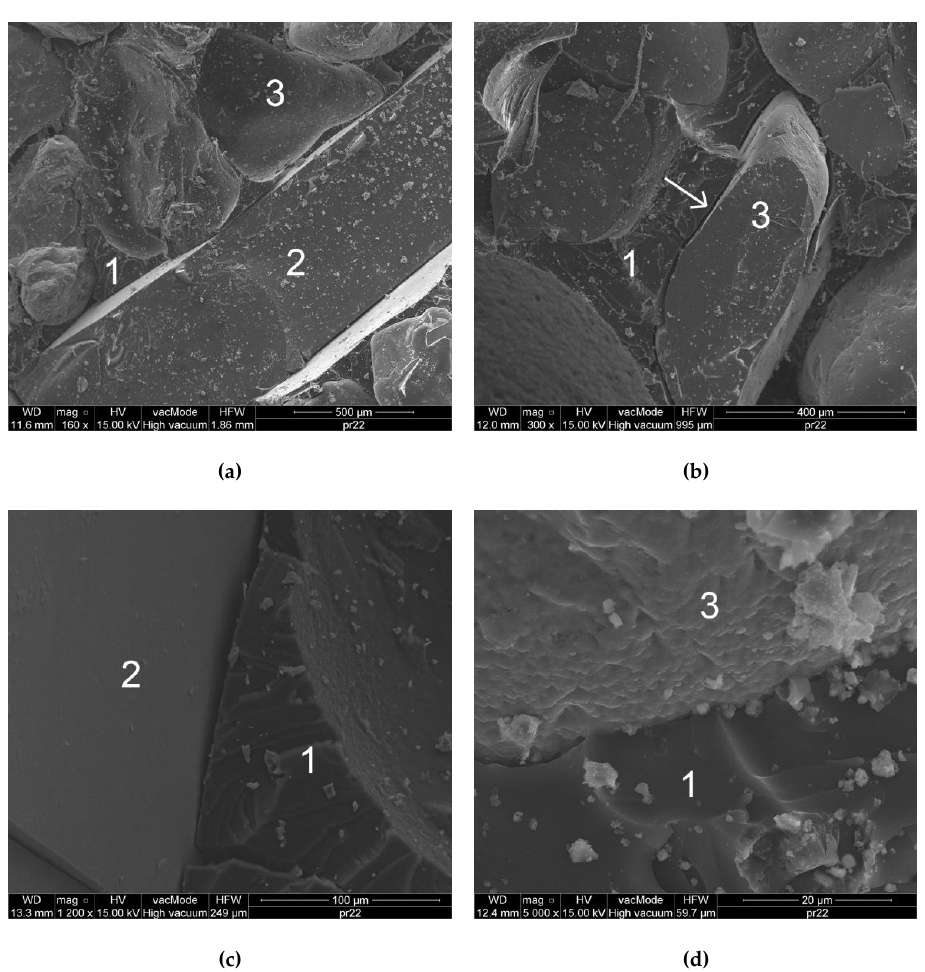
Figure 9. SEM photos of the CG-50 Polymer Concrete Microstructure: ( a ) Sand and Gravel Aggregate (SGA) and RGA Grains Surrounded by a Polymer Matrix; ( b ) SGA Grain Detached from the Matrix; ( c ) Contact of RGA with the Resin Matrix; ( d ) Contact of SGA with the Resin Matrix; 1 – polymer matrix; 2 – RGA grain; 3 – SGA grain.